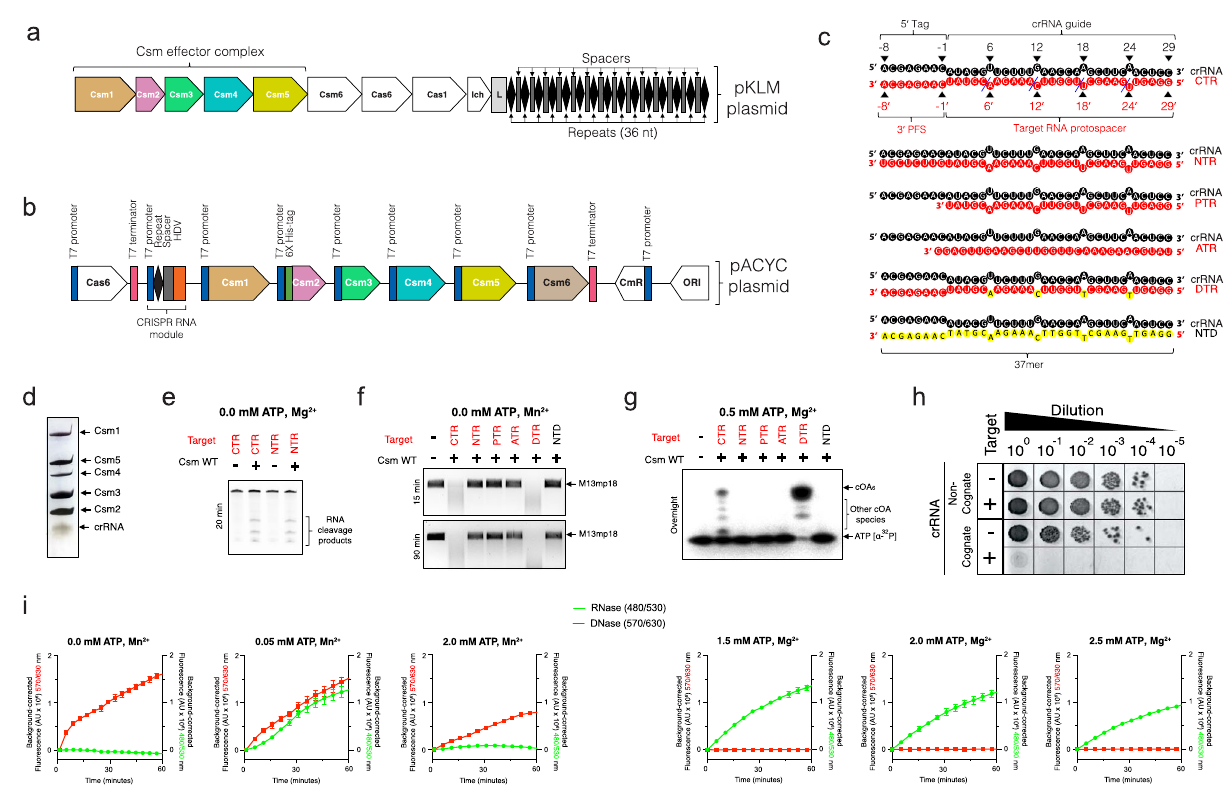
Fig. 1 Puri fi cation and activity of Lactococcus lactis type III-A (Csm) CRISPR-Cas system ( a ) Genome organization of Type III-A CRISPR-Cas system in pKLM plasmid of Lactococcus lactis . The locus harbors tandem copies of 36 nt repeats (diamonds) and spacers (rectangles) of varying lengths. b Schematic representation of pACYC expression plasmid harboring L. lactis CRISPR-Cas genes Csm1-6, Cas6, and CRISPR RNA locus in a HDV ribozyme construct. c Schematic representation of crRNA and various crRNA-target RNA duplexes used in the study ( crRNA : CRISPR RNA, CTR : cognate target RNA, NTR: non- cognate target RNA, PTR: protospacer target RNA, ATR: anti-sense target RNA, DTR: deoxy-substituted target RNA, NTD: non-target DNA). The blue dashed lines indicate target RNA cleavage sites. Deoxynucleotides are highlighted in yellow. d Silver stain pro fi le of puri fi ed LlCsm RNP showing Csm1-5 proteins and crRNA. e In vitro RNA cleavage assay by WT LlCsm complex. The reactions were performed at 37 °C for 20 min and contained 100 nM LlCsm complex and 500 nM target RNA. f In vitro DNA cleavage assay by WT LlCsm complex. The reactions were carried out with 100 nM LlCsm complex, 200 nM target RNA on M13mp18 at 37 °C for 10 – 90 min as indicated in a cleavage buffer containing 33 mM Tris-acetate pH 7.6 (at 32 °C), 66 mM potassium acetate, and 10 mM MnCl 2 . g Urea-polyacrylamide gel electrophoresis (Urea-PAGE) showing cOA synthesis by LlCsm complex. The reactions were carried out at 37 °C overnight with 100 nM LlCsm complex, 200 nM target RNA, 500 μ M cold ATP spiked with [ α - 32 P]-ATP in a buffer containing 33 mM Tris-acetate pH 7.6 (at 32 °C), 66 mM potassium acetate, and 10 mM MgCl 2 . h In vivo plasmid interference assays with the wild type LlCsm harboring a non-cognate crRNA or the wild type LlCsm harboring a cognate crRNA. i Dual fl uorescence assay using DNA and RNA oligo reporters with 5 ′ Alexa Fluor 594 fl uorophore/3 ′ Iowa Black RQ quencher and 5 ′ 6-FAM fl uorophore/3 ′ Iowa Black FQ quencher, respectively. The Csm1-mediated DNase and the Csm6-mediated RNase are simultaneously detected at 570/630nm excitation/emission (red) and 480/530 nm excitation/emission (green) wavelengths, respectively. Target RNA (CTR) was used as the stimulator at 500 nM, LlCsm at 200 nM, LlCsm6 at 1 nM, and metal ions at 10 mM. Curves are averages with error bars of three technical replicates subtracted by the signals from water-stimulated